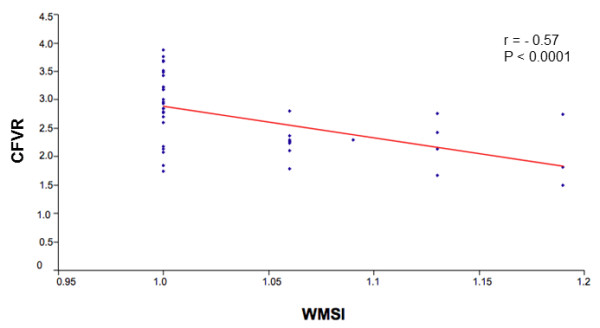
Inverse correlation between CFR and WMSI in examined SSc patients. Relationship between coronary flow reserve (CFR) and wall motion score index (WMSI) in systemic sclerosis patients. WMSI = difference between rest and peak WMSI (0 to 1 minute after the end of peak dose).